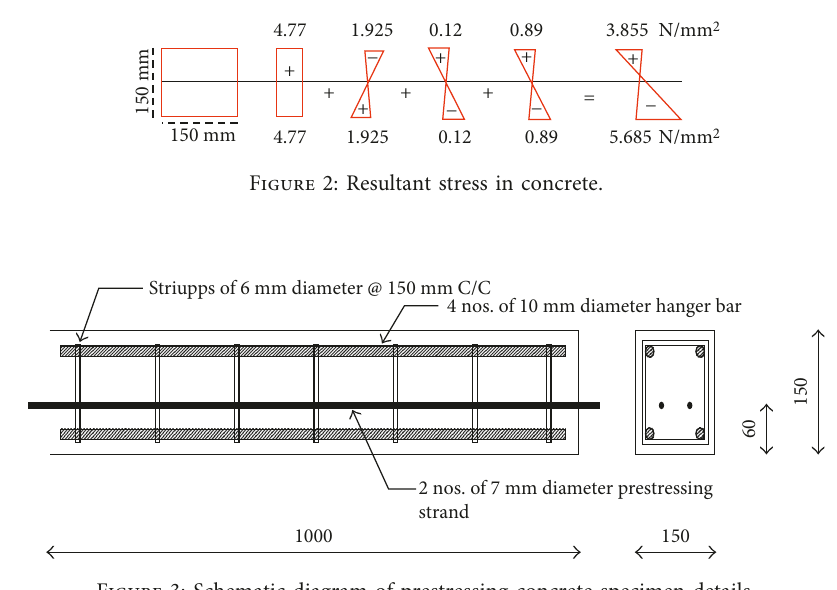
Figure 3: Schematic diagram of prestressing concrete specimen